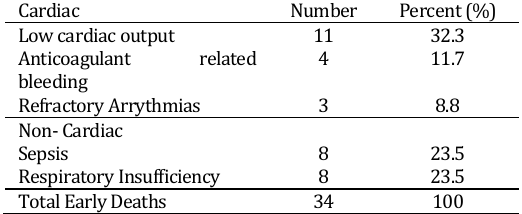
Table 2. Causes of early death after double valve replacement Cardiac